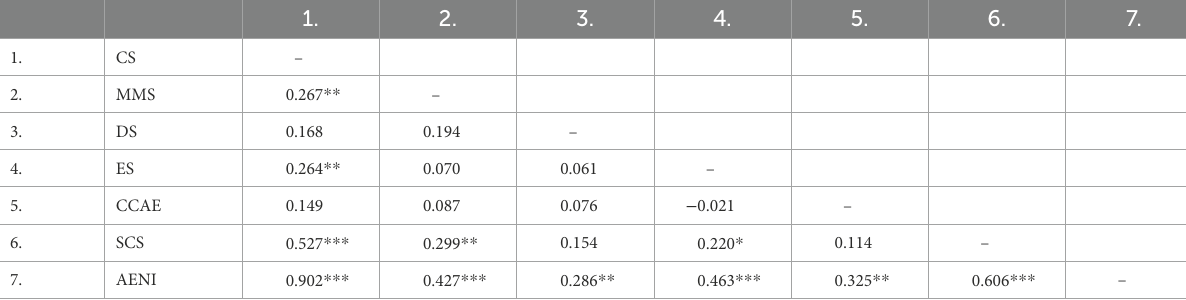
TABLE 4 Inter-correlations for AENI ( N = 98) measurement and overall